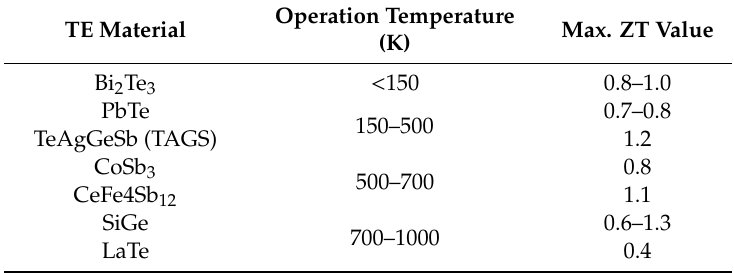
Table 1. The characteristic of selected thermoelectric materials adapted from